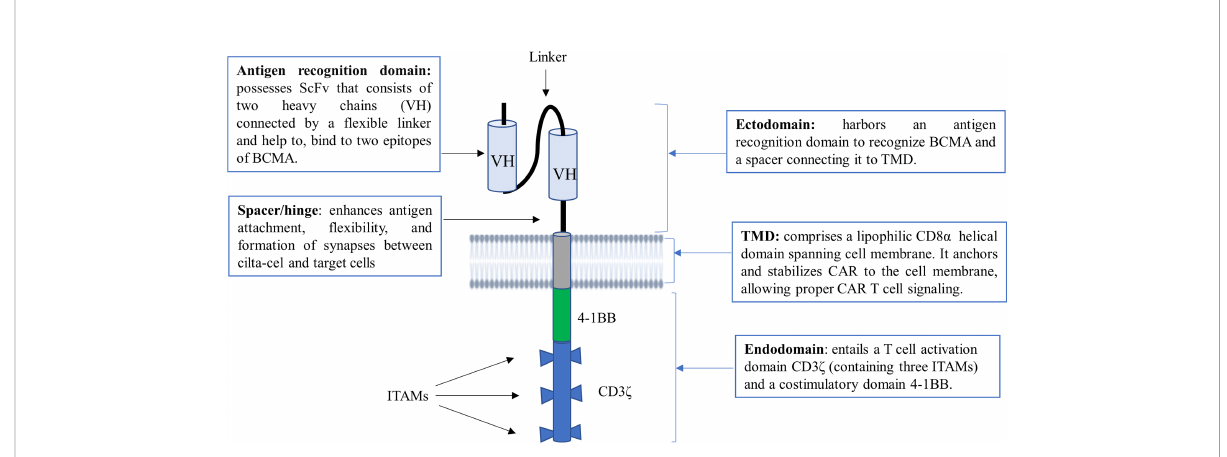
FIGURE 1 The structural construct of cilta-cel. It is a second-generation CAR T-cell containing an ectodomain, a TMD, and an endodomain. ScFv, short chain variable fragment; TMD, transmembrane domain; VH, variable heavy chain; BCMA, B cell maturation antigen; ITAM, immunoreceptor tyrosine-based activation